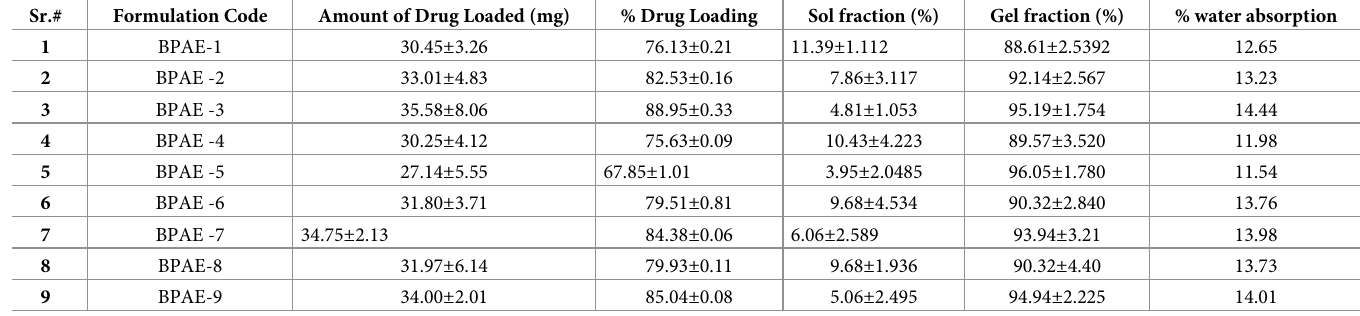
Table 4. Drug loading and drug loading percentage, Sol-Gel fraction and % water content of all β CD/PVP-co-poly (AMPS) nanogels.